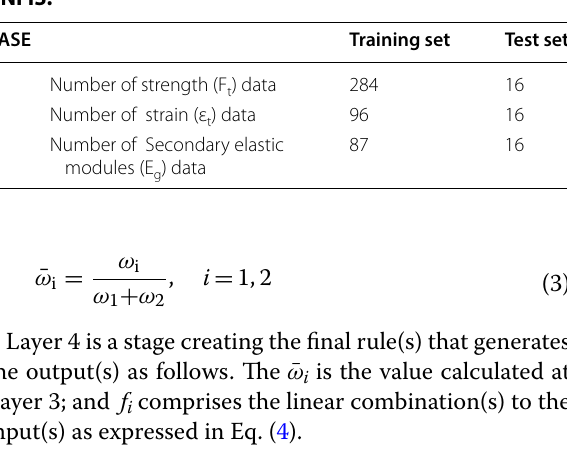
Table 1 Prediction design for confined concrete using